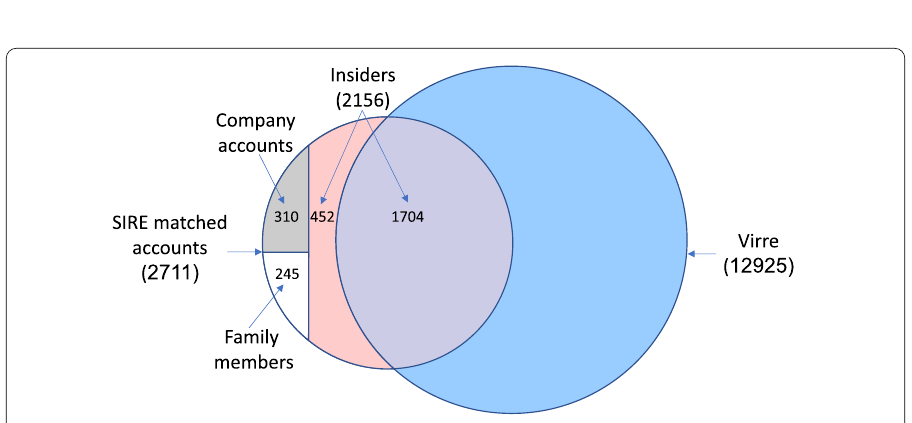
Figure 2 The matched data set is composed of insiders observed in the Virre and SIRE data sets. Overall, the temporal insider network is composed of 13,932 insiders and their related parties. The 12,925 insider observed in the Virre data set are complemented by 1007 insiders that have been included in the SIRE data set, and were matched with their trading accounts in Euroclear data set. 245 of them belonged to insiders’ family members, 310 belonged to related company’s accounts, and 452 belonged to insiders that were not recorded in Virre data set